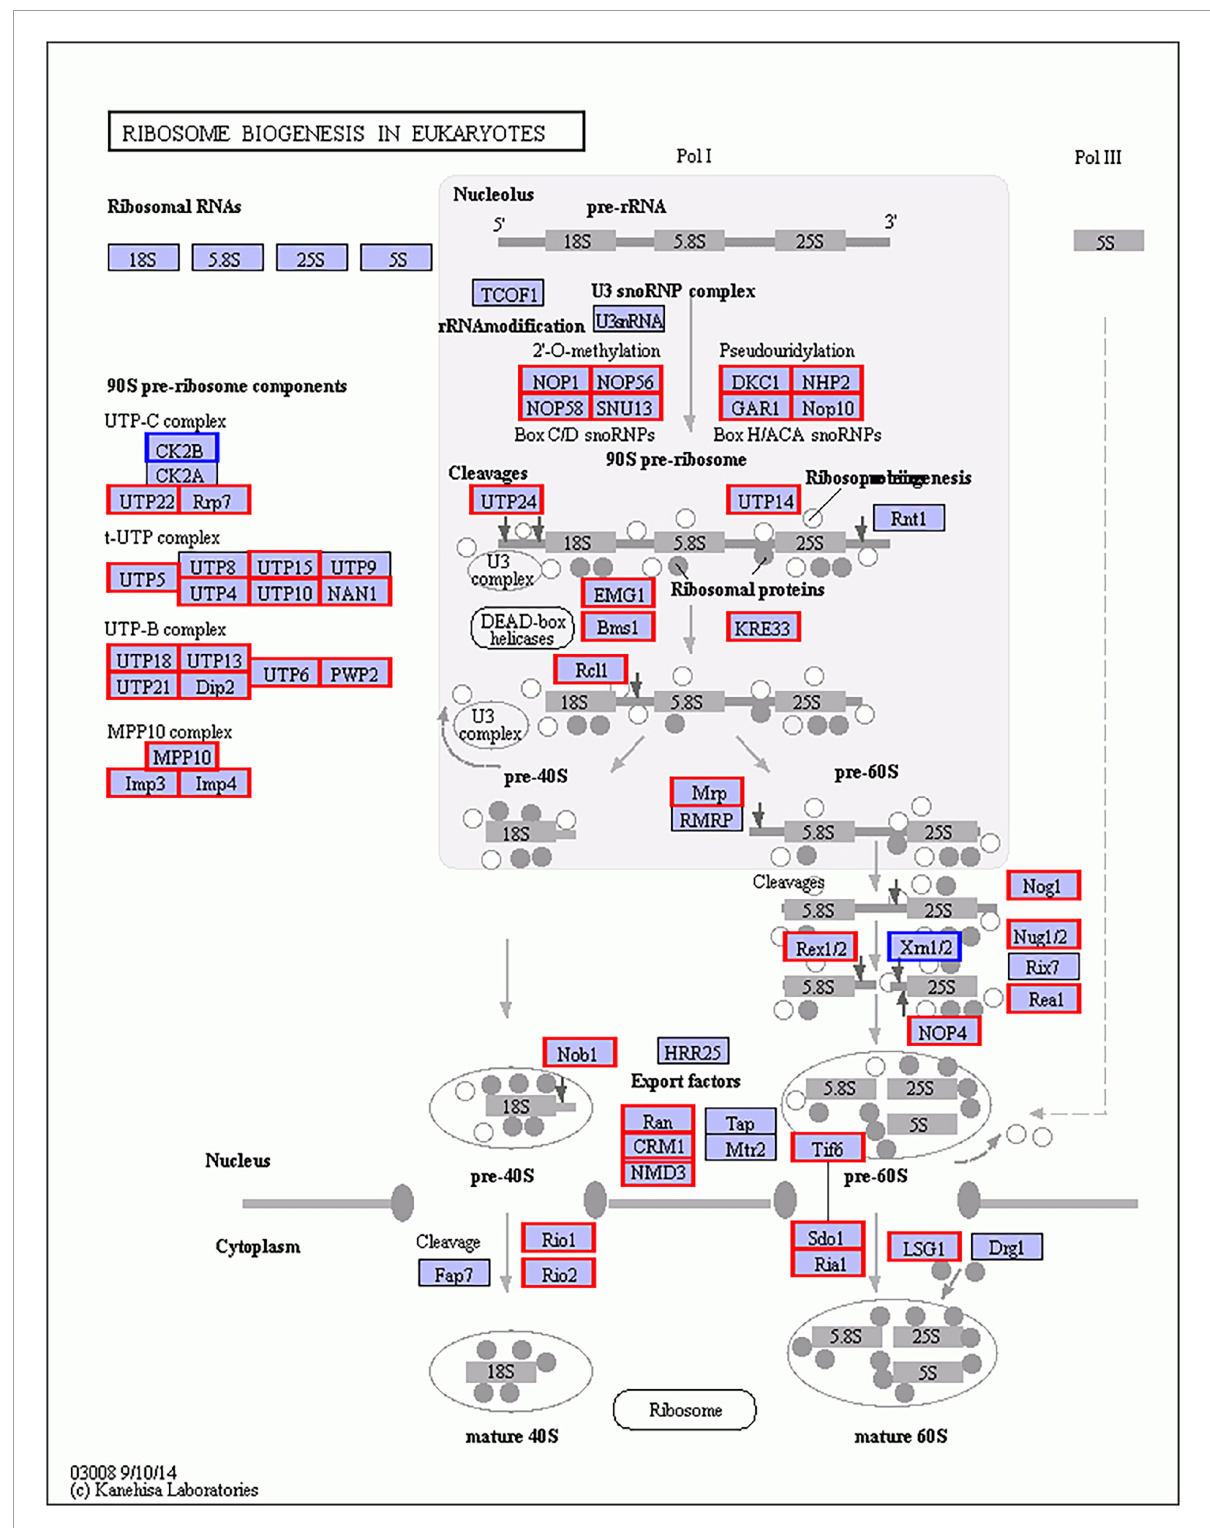
FIGURE8 Up- and down-regulated genes of ko03008 KEGG pathway of in paired comparison of Gm-Ba vs. Gm. ko03008, ribosome biogenesis in eucaryotes. The genes with red or blue border in the figure were differentially expressed genes, where red and blue represents up- and down-regulated genes,